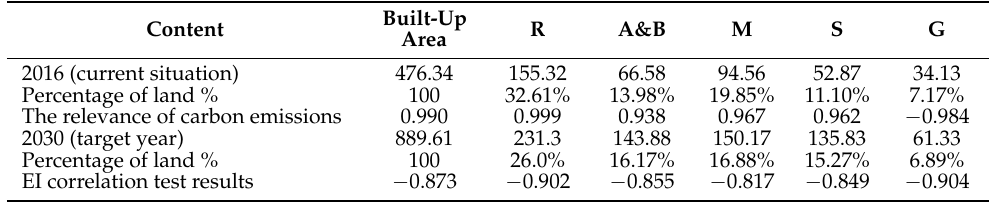
Table 10. The setting value of the urban morphology indices of Changsha city in 2030.